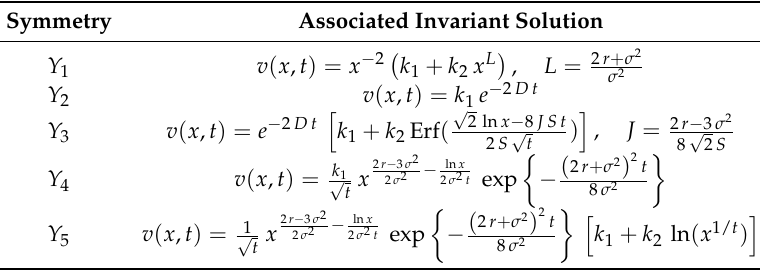
Table 2. Invariant solutions of the adjoint Equation